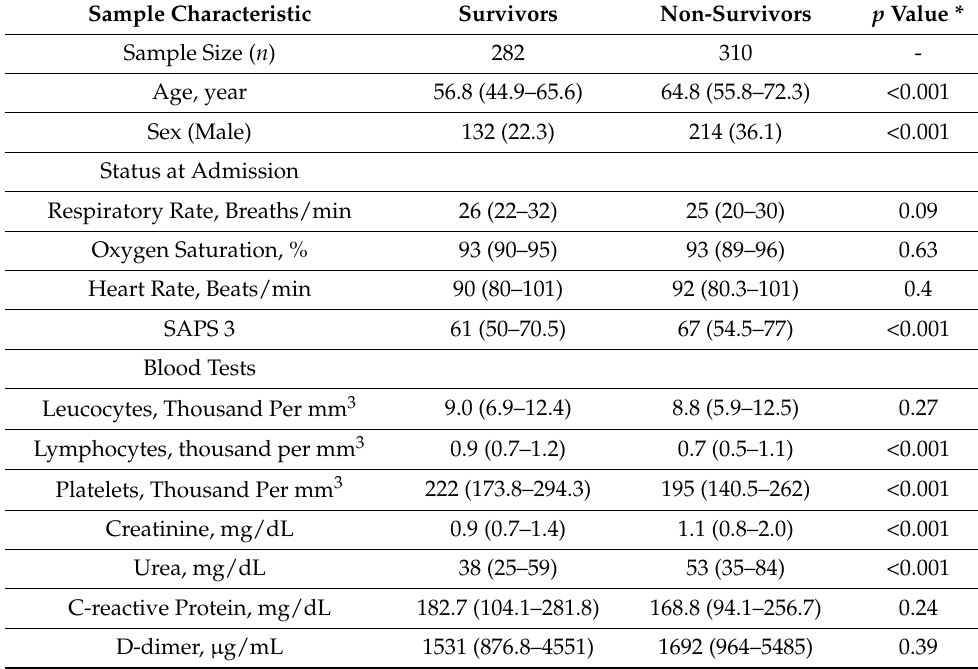
Table 1. Baseline characteristics according to outcomes.